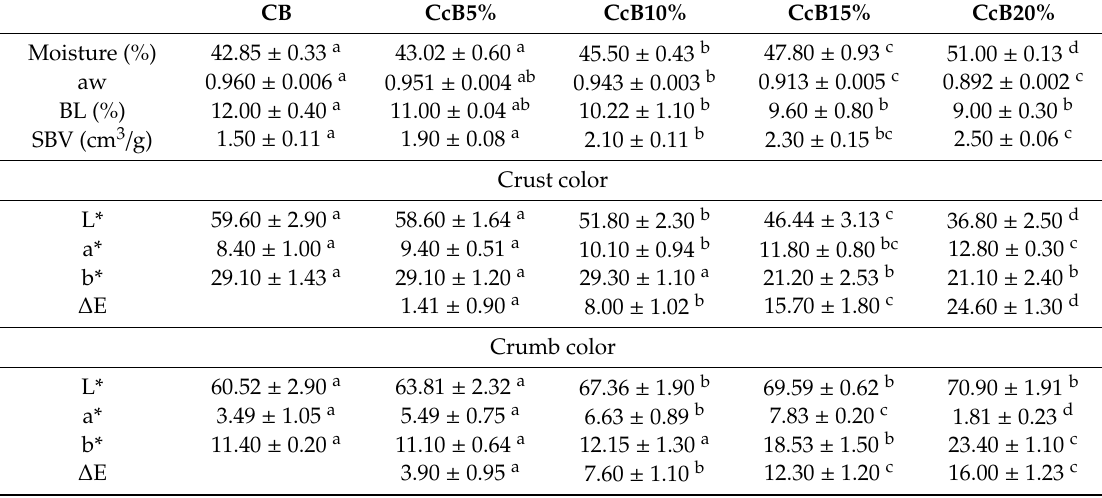
Table 5. Bread quality parameters: moisture, water activity (aw), baking loss (BL), specific bread volume (SBV), and bread crust and crumb color, for control bread (CB) and curd cheese breads (CcB5% up to